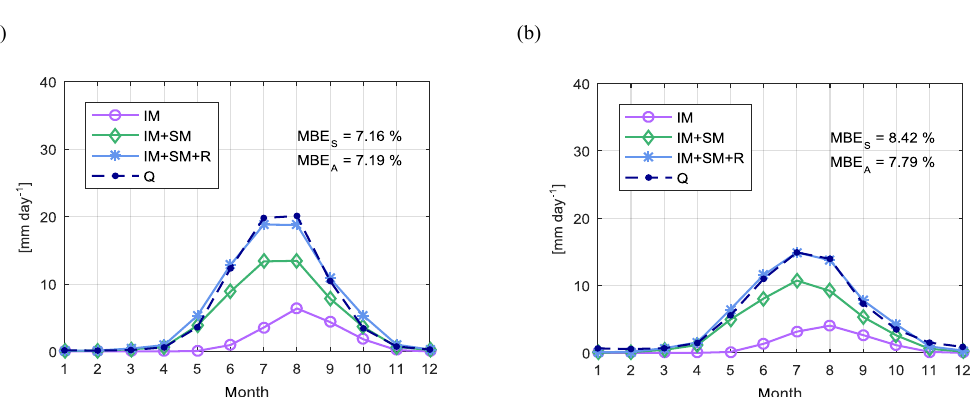
Figure 4. Comparison of mean monthly observed (dark blue) and simulated (light blue) discharge for the period 1975–2015: (a) Massa basin and (b) Lonza basin. Simulated discharge is the sum of three components: ice melt (IM), snowmelt (SM), and rainfall ( R ).